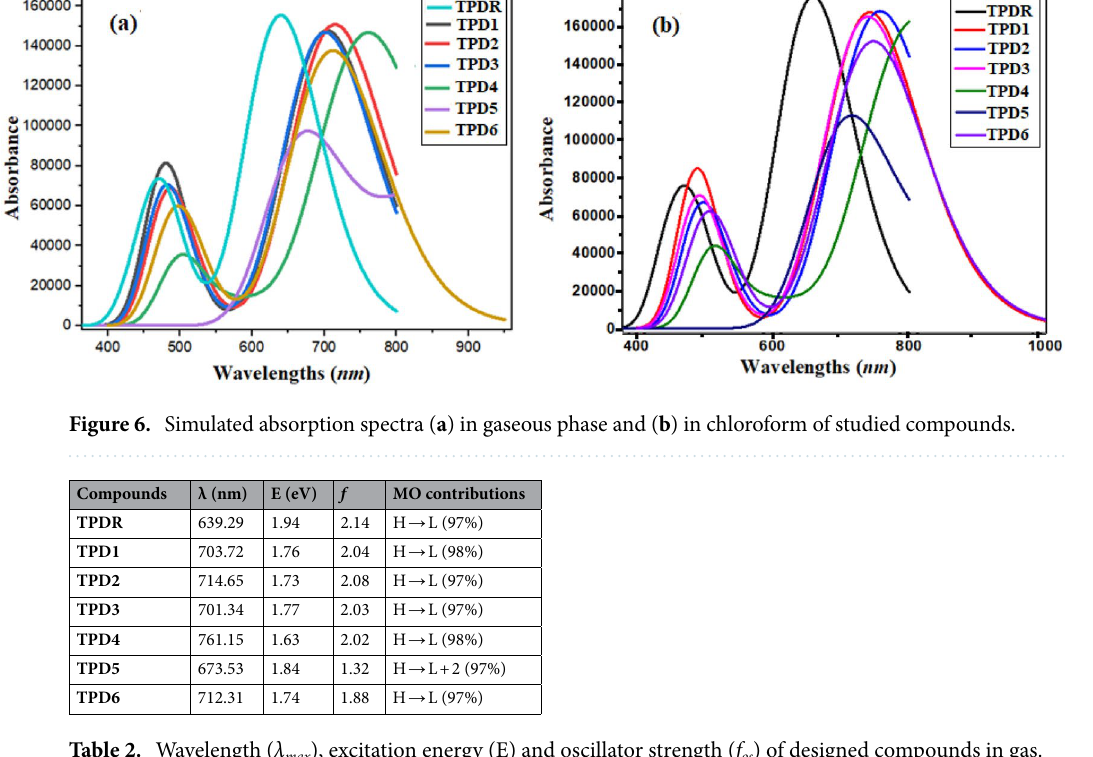
Table 2. Wavelength ( λ max ), excitation energy (E) and oscillator strength ( f os ) of designed compounds in gas. MO molecular orbital, H HOMO, L LUMO.